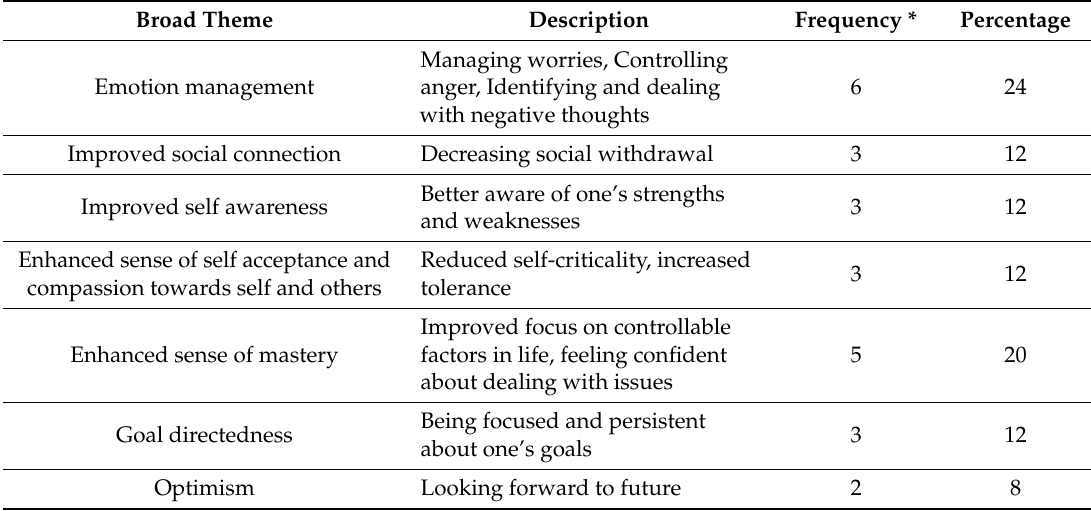
Table 11. Excerpts of general feedback by users (verbatim).